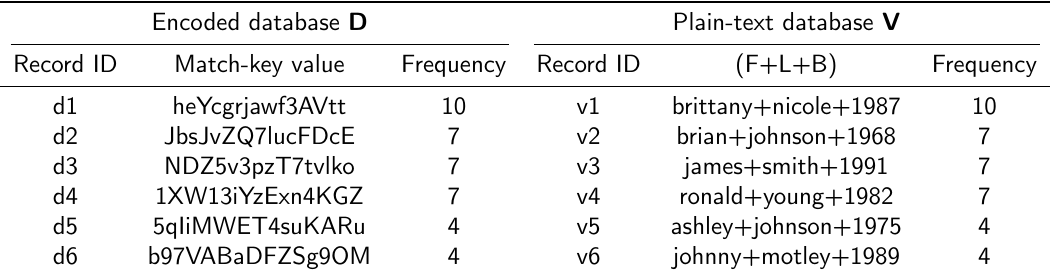
Table 3: An example of plain-text alignment for match-key FirstName+LastName+BirthYear (F+L+B) using frequency values of match-key values and plain-texts values. As discussed in step 5 of the attack, record d1 from the encoded database D will be aligned with record v1 from the plain-text database V . Since all three records d2, d3, and d4 have a frequency of 7 and the three records v2, v3, and v4 in the plain-text database also have the same frequency, we assign each of d2, d3, and d4 to all three values of v2, v3, and v4. Similarly, we assign each of d5 and d6 to both values of v5 and v6 since they all have a frequency of